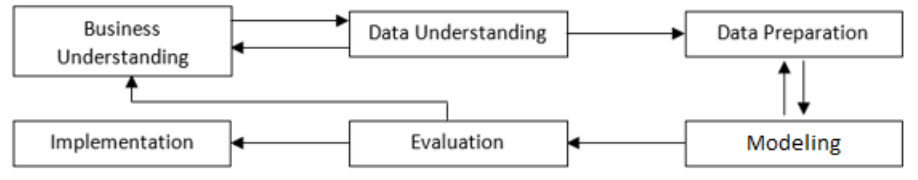
Figure 2. CRISP-DM methodology